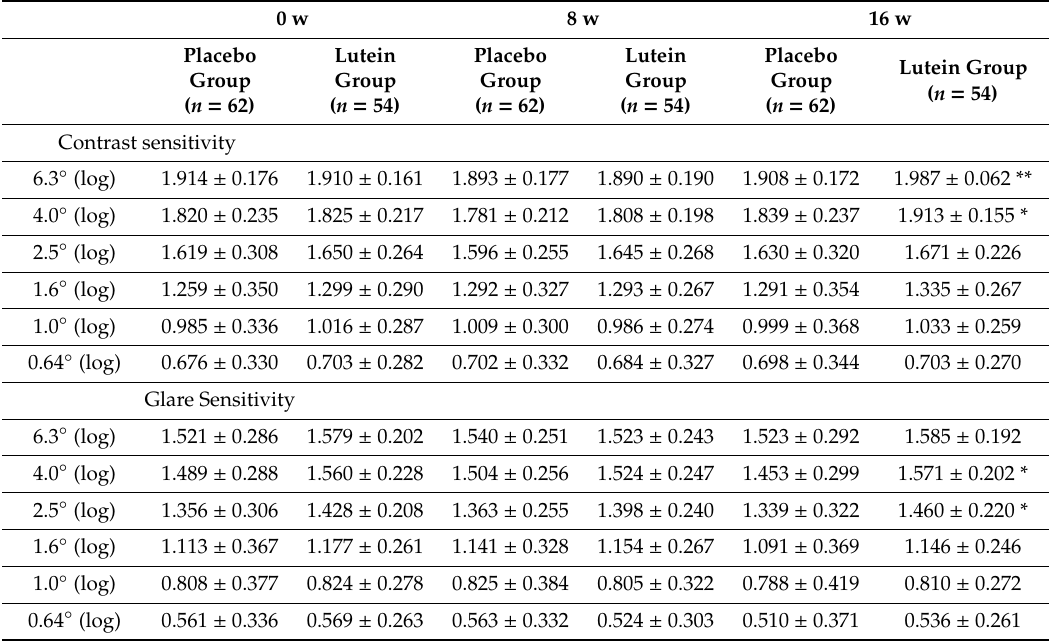
Table 5. Changes in contrast and glare sensitivities during supplementation.